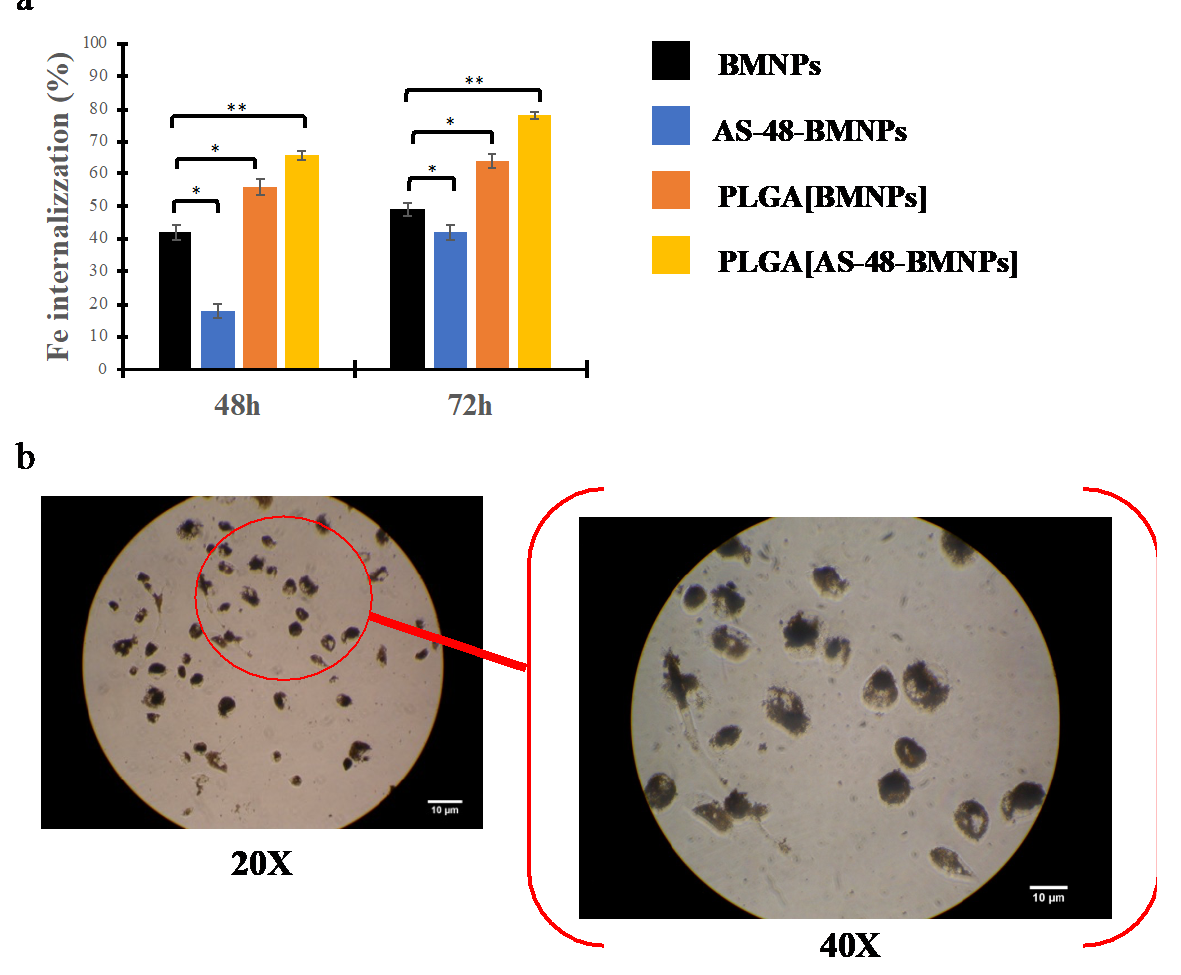
Figure 6. ( a ) Quantitative analysis of BMNPs by measuring the Fe content inside the macrophages after 48 and 72 h in TH1-P cell line following treatment with BMNPs (229 µ g/mL), AS-48-BMNPs (229 µ g/mL BMNPs and 32 µ g/mL AS-48), PLGA[BMNPs] (457 µ g/mL PLGA, 229 µ g/mL BMNPs), PLGA[AS-48-BMNPs] (457 µ g/mL PLGA, 229 µ g/mL BMNPs and 32 µ g/mL AS-48). ( b ) Brightfield microscopy of THP-1 cells treated 72 h with PLGA[AS-48-BMNPs] * p ≤ 0.05, ** p ≤ 0.001.